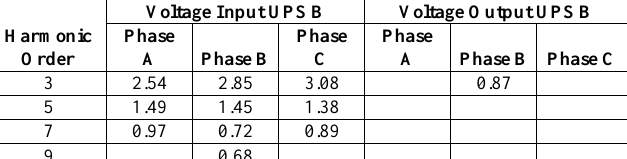
Figure 8: Voltage output from UPS B. Table 3: Comparison of the voltage of UPS B.